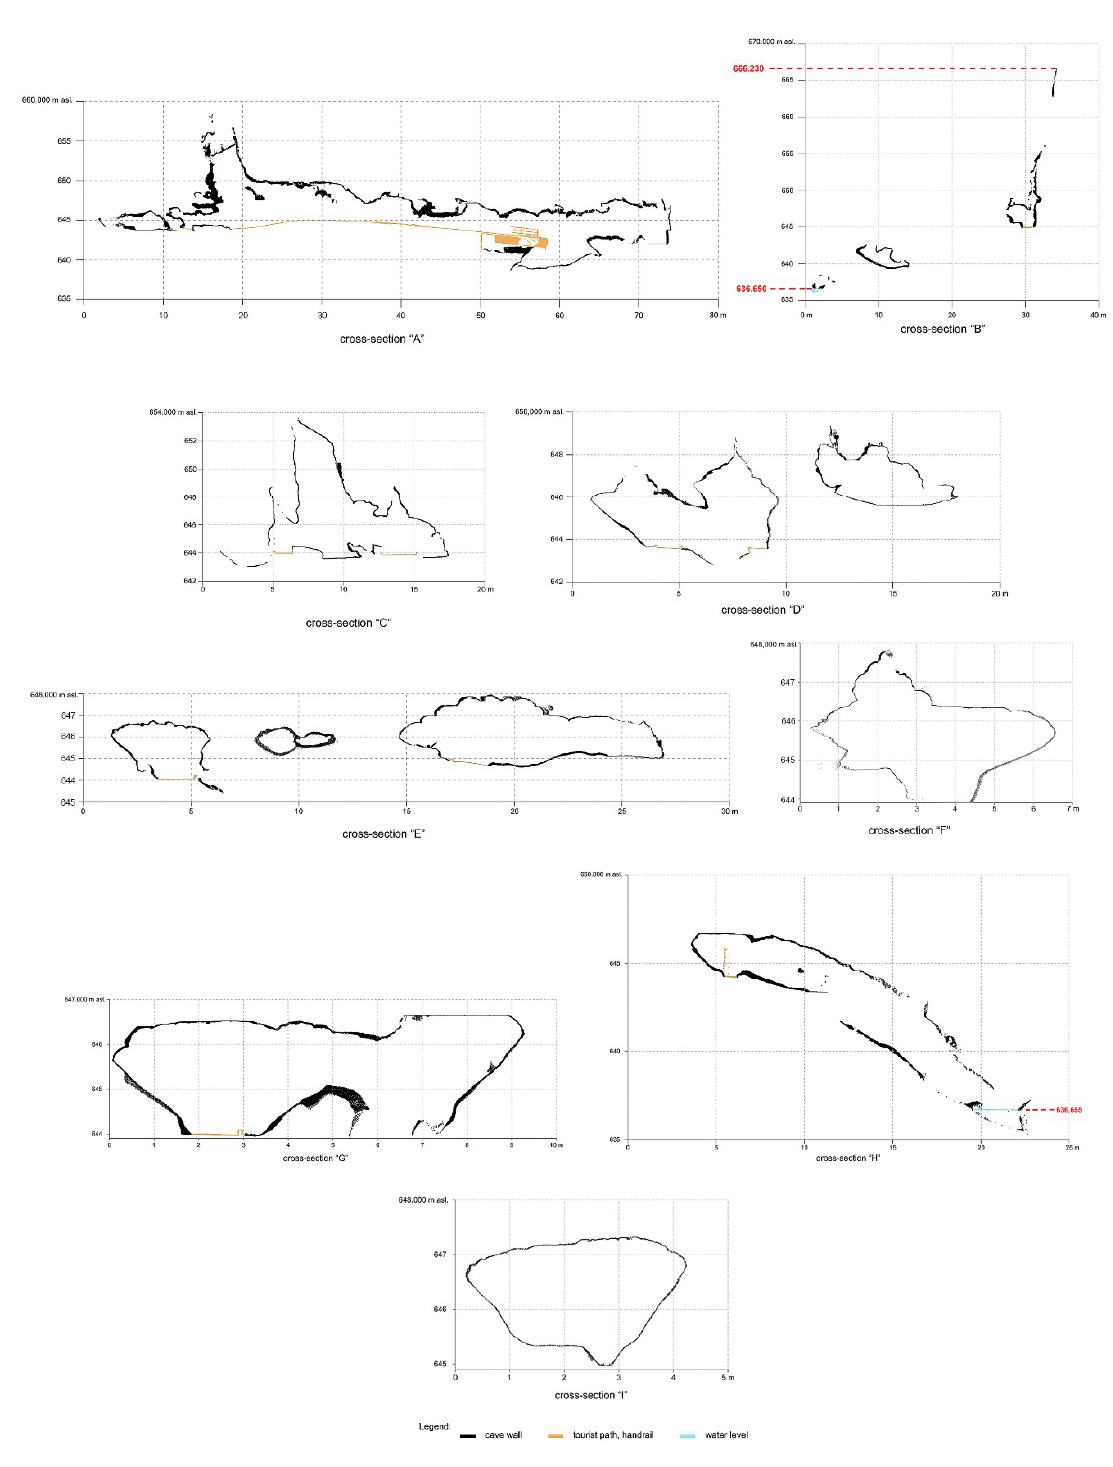
Figure 7. Cross-sections “A”–“I” of the cave through the final point cloud.